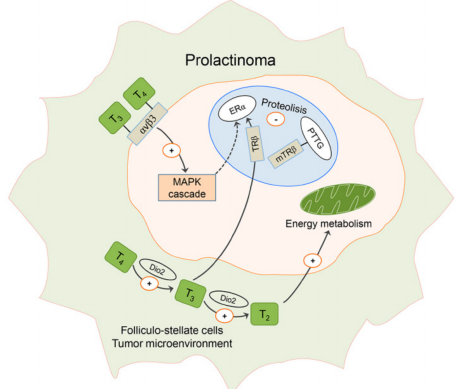
Figure 6. Hypothetic role of enhanced thyroid hormone signaling in prolactinoma. Deiodinase type 2 (Dio 2) expression in folliculo-stellate cells is increased in prolactinomas, which may lead to increased production of l -triiodothyronine (T 3 ) and 3,5-T 2 (T 2 ) from l -thyroxine (T 4 ) in the pituitary . T 3 - thyroid receptor (TR) β complex prevents proteolisis of estrogen receptor (ER) α in the cell nucleus, while mutated thyroid receptor (mTR β ) binds to pituitary tumor transforming gene (PTTG), thus preventing its proteolysis. Both T 4 and T 3 may bind to its membrane integrin α v β 3 receptor and activate mitogen-activated protein kinase (MAPK) cascade and phosphorylation processes, including ER α phosphorylation (dashed arrow). Increased concentration of T 2 , demonstrated in pituitary adenomas, may contribute to progression of prolactinoma through stimulation of energy metabolism in mitochondria